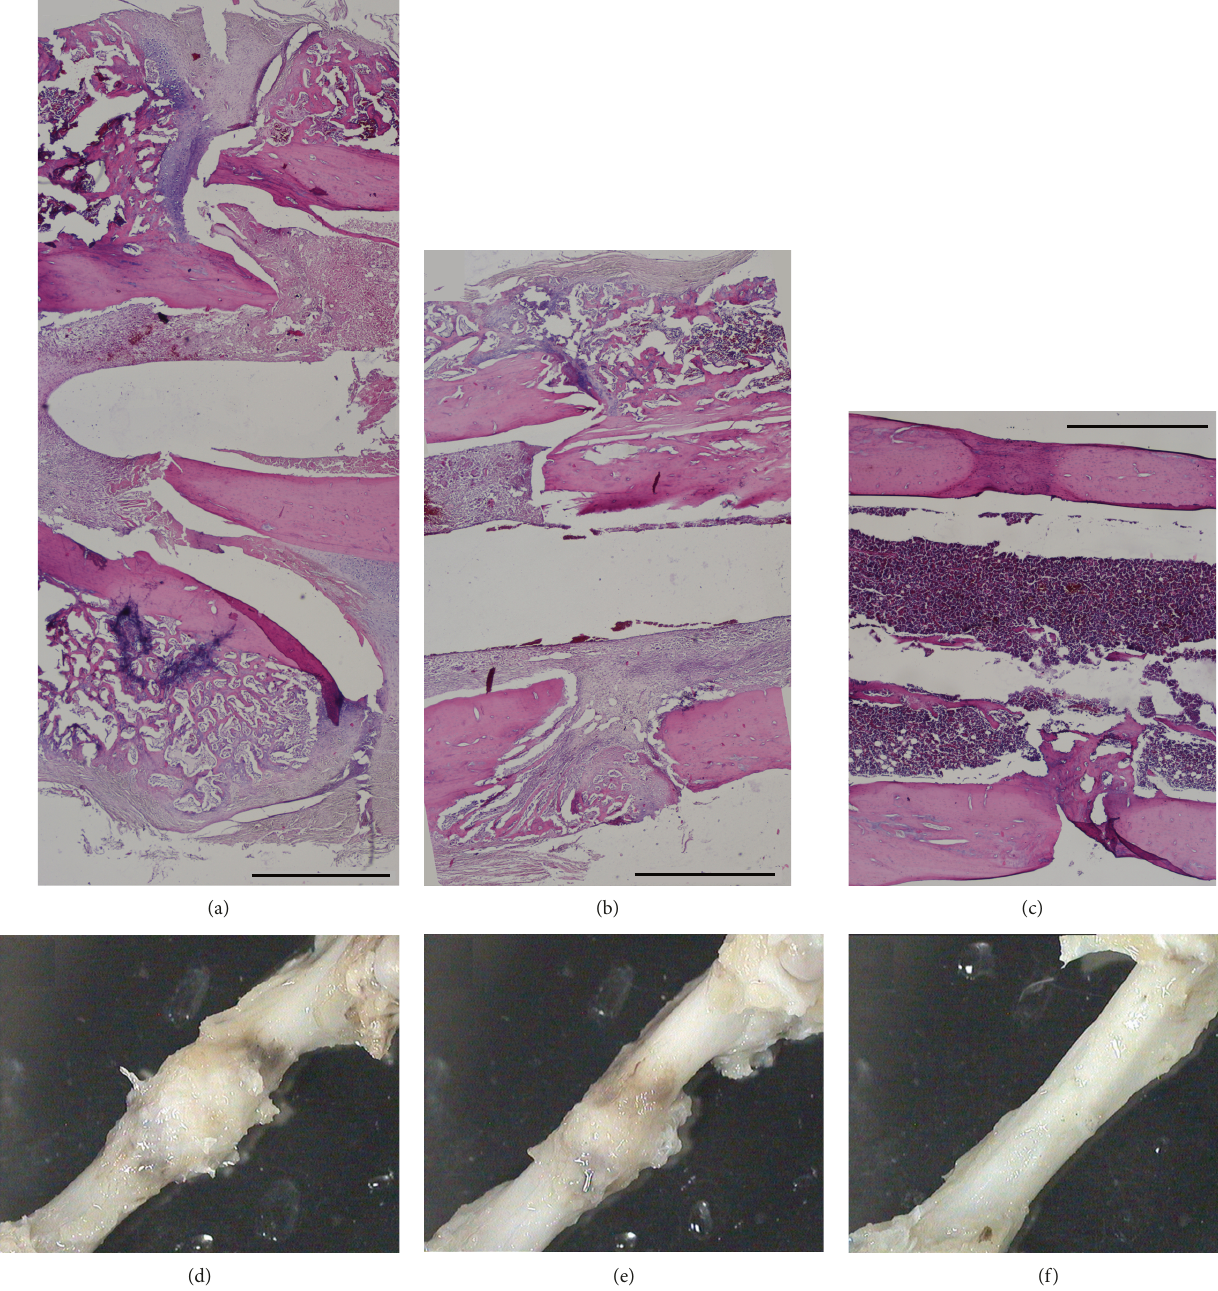
Figure 5: The gross (a, b, c) and microscopic (d, e, f) appearances of osteotomy sites in all three groups at the end of the fourth week. At the end of the fourth week, both sham (a and d) and control-sheet groups (b and e) exhibited bony callus at the fracture site with a slightly accelerated healing pro fi le in the control group, that is, the callus size was smaller (e versus d) suggesting remodeling towards the healing process. However, in both sham and control-sheet groups, fracture ends were still apart from each other (a, b). In the osteogenic-sheet group (c, f), on the other hand, fracture site was already fi lled with bone tissue and fracture site entered to the bone remodeling stage. Scale bar =1 mm for (a, b,